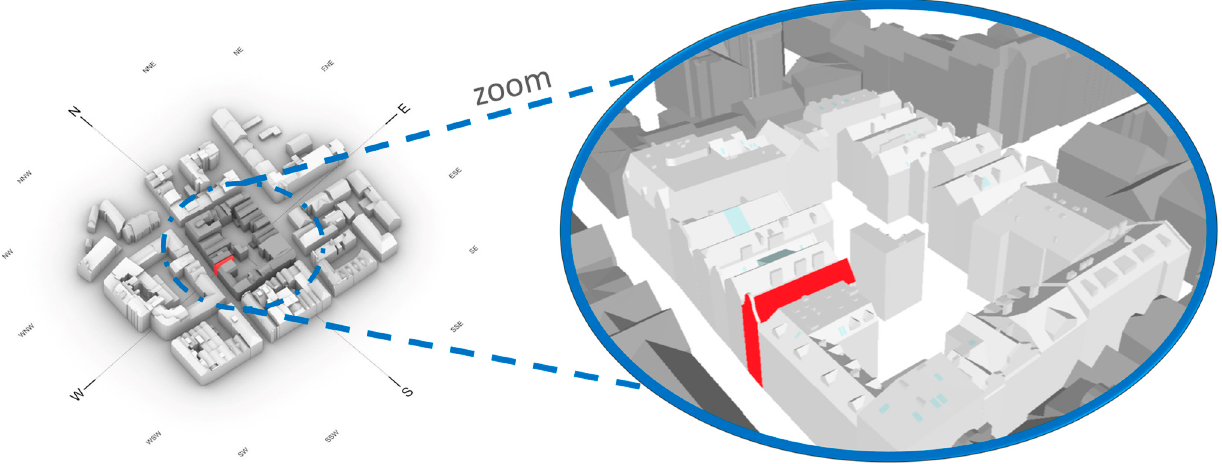
Figure 7. A 3D model of the analysed block with directly neighbouring buildings.